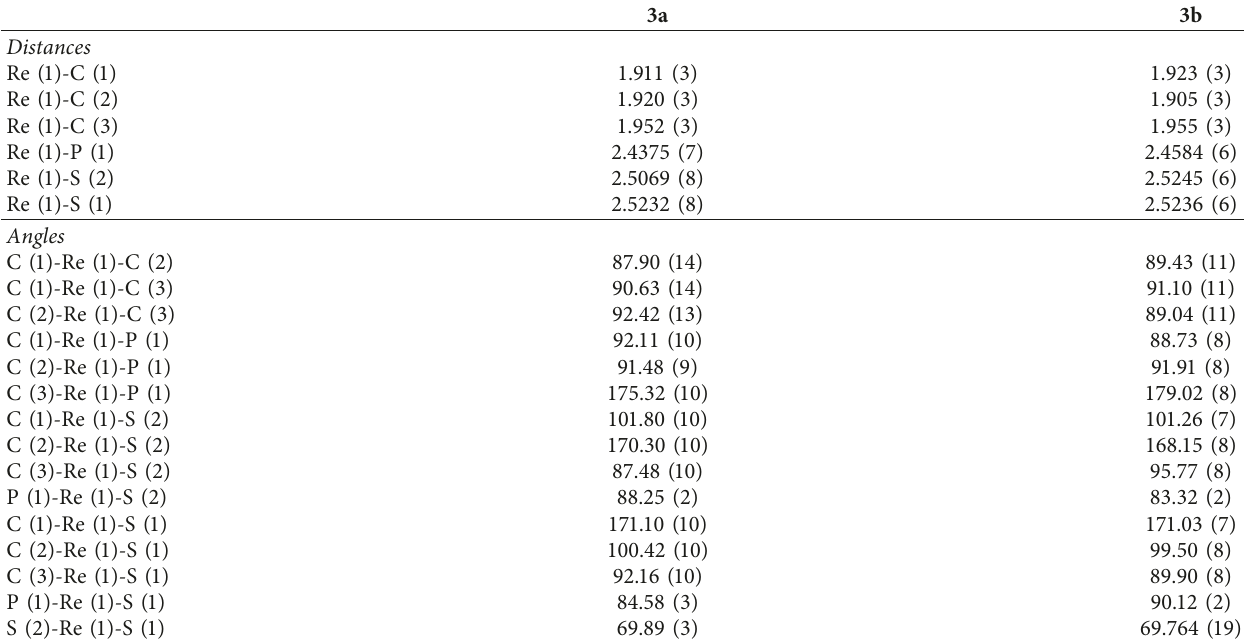
Table 4: Selected bond distances (˚A) and angles ( ° ) for 3a and 3b .